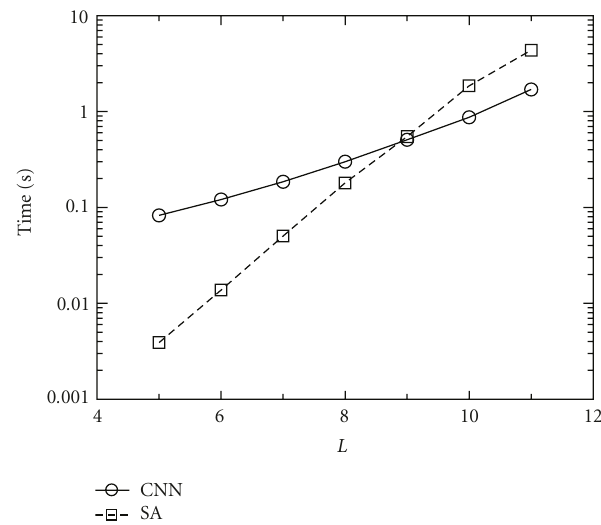
Figure 4: (a) Time needed to reach the minimum energy as a function of the lattice size L . Circles are for estimates on CNN computers and squares are simulated annealing results on 3.4GHz Pentium 4. Results are averaged on 10 000 di ff erent configurations with P = . 4 probability of positive bonds. For the CNN algorithm, Δ b = 0 . 05 was chosen. For simulated annealing, the initial temperature was T 0 = 0 . 9, final temperature T f = 0 . 2, and the decreasing rate of the temperature was fixed as 0 .